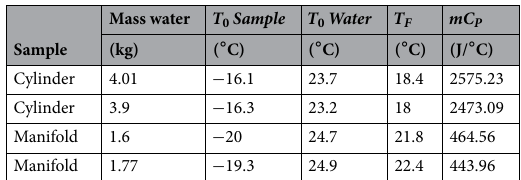
◦ C) of the cylinder and the manifold.